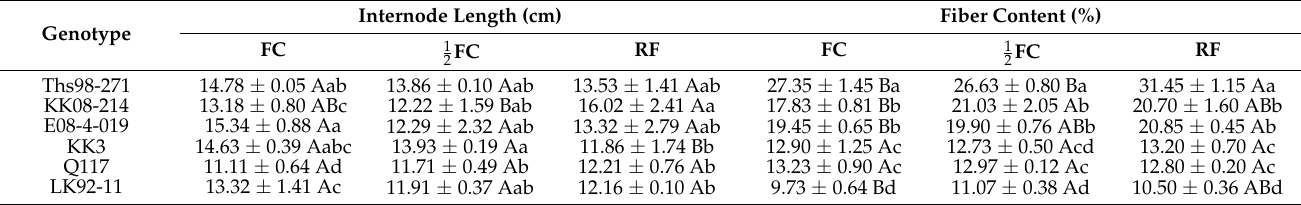
Table 11. Internode length and fiber content of six sugarcane genotypes grown under well-watered (FC) and water-stressed FC and RF) ( 1 2